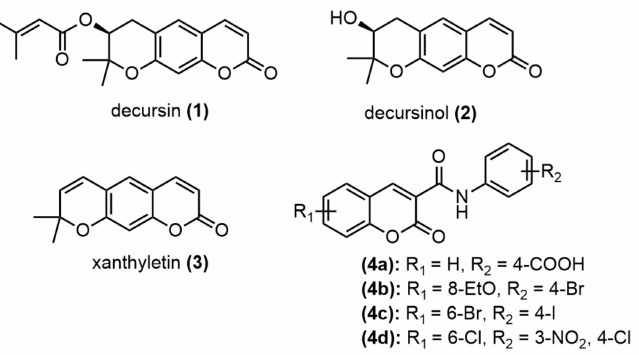
Figure 1. Synthetic and natural-occurring coumarins with biological